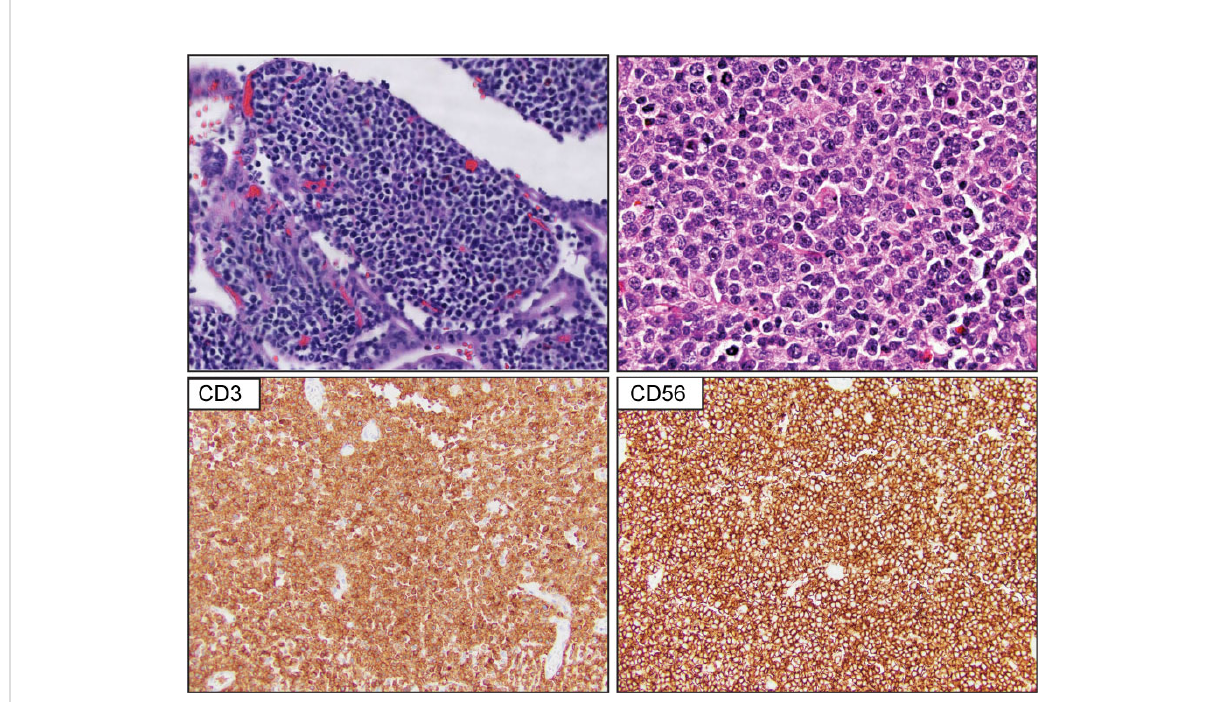
FIGURE 2 Monomorphic epitheliotropic intestinal T-cell lymphoma (MEITL). Upper panel show representative H&E images that highlight extensive epitheliotropism by medium size lymphocytes with a homogeneous appearance. The lower panel demonstrates that the atypical lymphocytes are composed of CD3-positive and CD56-positive T-cell